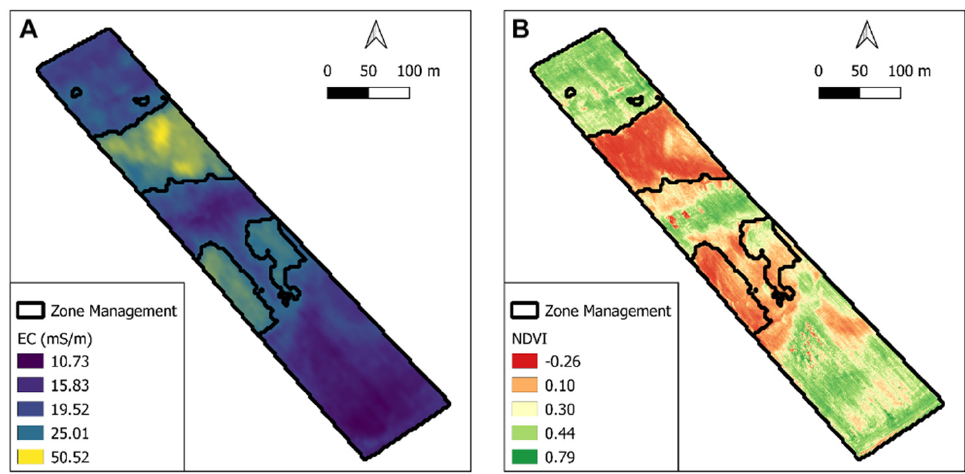
Figure 6. Overlapping of the resistivity map ( A ) and NDVI during flowering ( B ) and the zone man- agement defined by the cluster analysis.